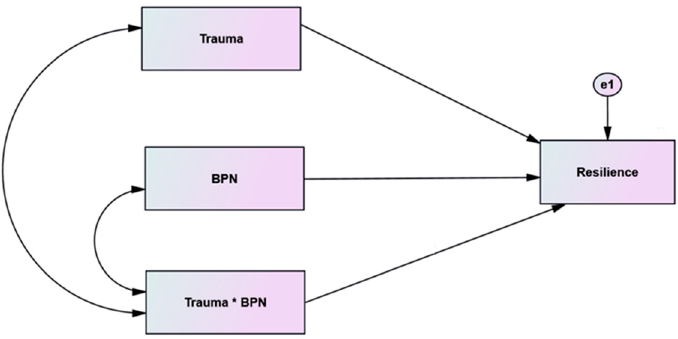
Figure 2. Hypothesized Structural Model (the effect of interaction of trauma and BPNS on resilience).